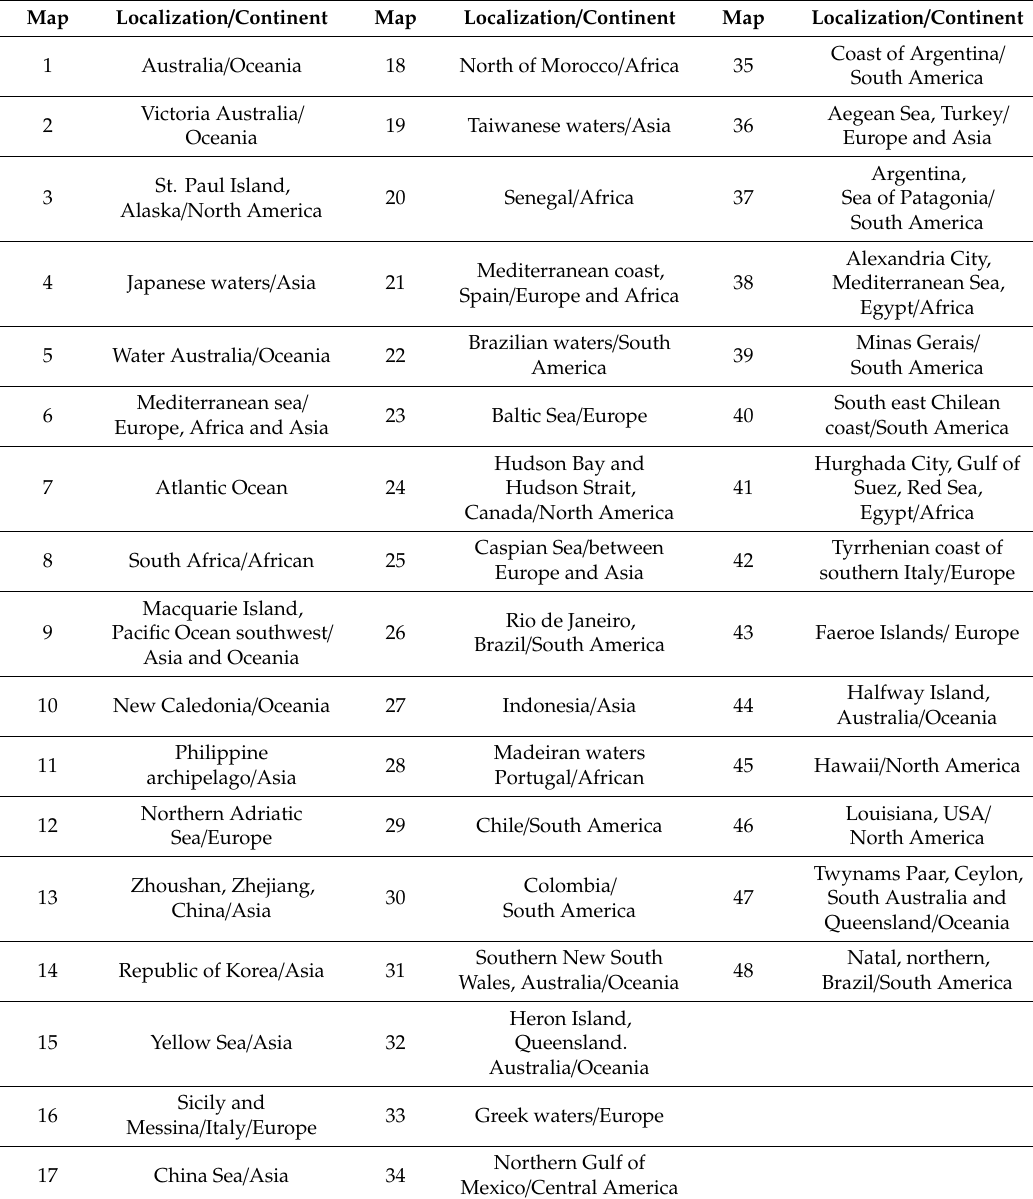
Table 2. Geographical localization of the Anisakidae family, identified by molecular tests in di ff erent countries and continents around the